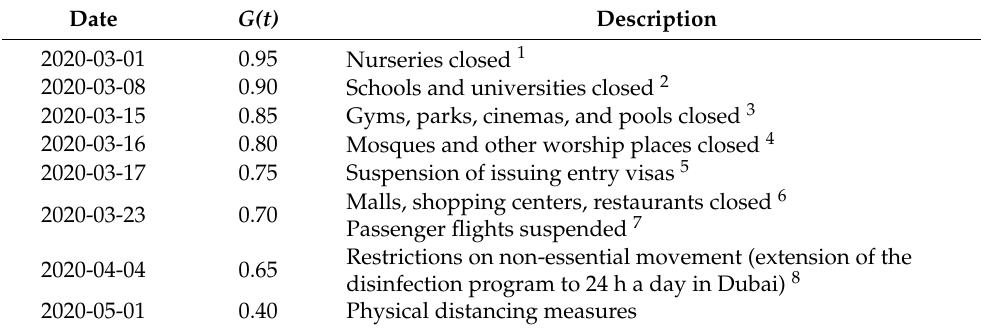
Table 1. The UAE Government public health intervention on mask wearing and physical distancing. By enforcing mask wearing in public places and physical distancing, the UAE Government introduces public health interventions and we quantify the effects of these measures as multiplier G(t) , which finally reduces the base transmission rate ( β t ). The values are assumed, and G(t) decreases as more measures are